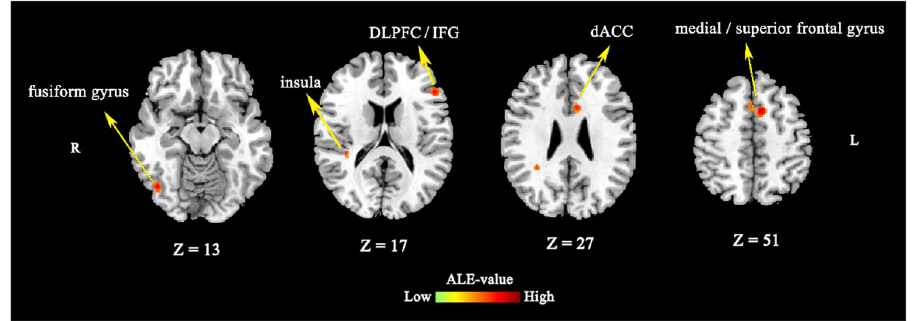
Figure 1. Brain activation underlying emotional interference of cognitive control in emotional Stroop task fMRI studies. DLPFC: dorsolateral prefrontal cortex; IFG: inferior frontal gyrus; dACC: dorsal anterior cingulate cortex. R: right side of the brain; L: left side of the brain. Clusters were displayed using a threshold at p < 0.05 (cluster-level,